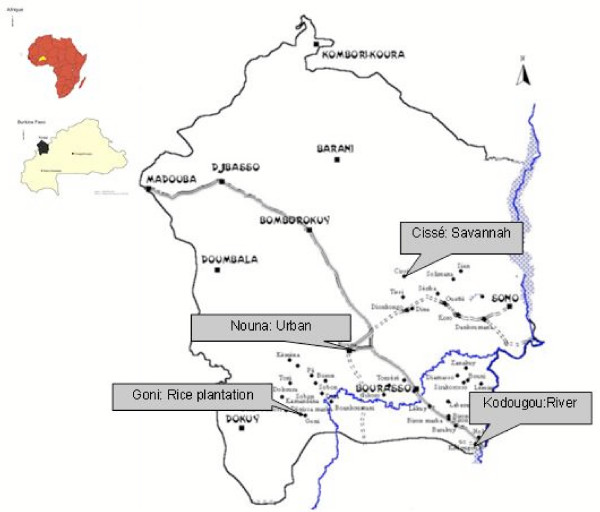
Location of the study sites in Nouna Health district (Kossi province).